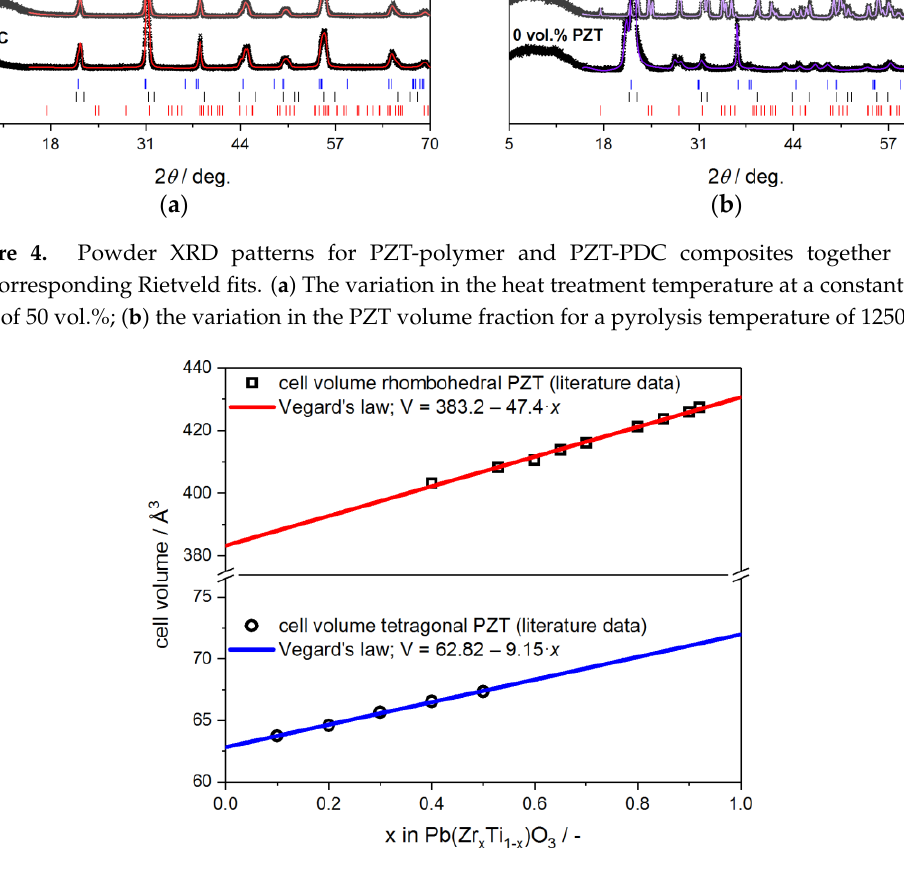
Figure 5. Literature data of the unit cell volume as a function of the Zr content x in rhombohedral (□) and tetragonal Pb(Zr x Ti 1- x )O 3 ( ○ ). The data were fitted by Vegard’s law, which was subsequently applied in determining the Zr content x in the PZT filler from its unit cell volume.